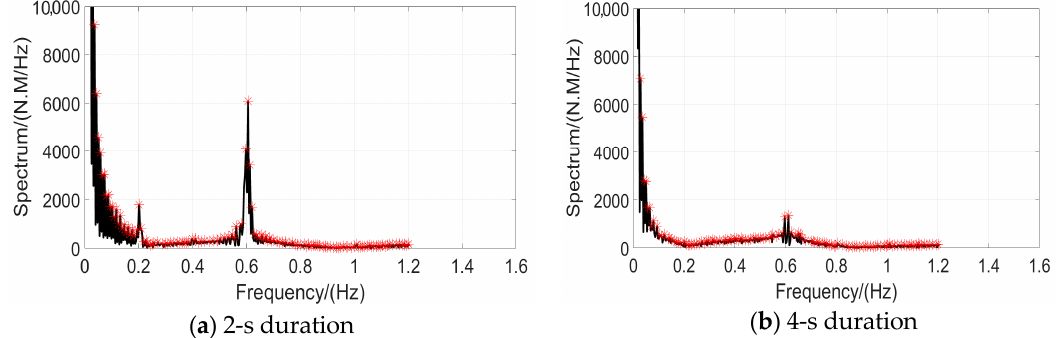
Figure 16. Frequency of rotor torque for a yawing start-stop process with a duration of 2-s and 4-s.